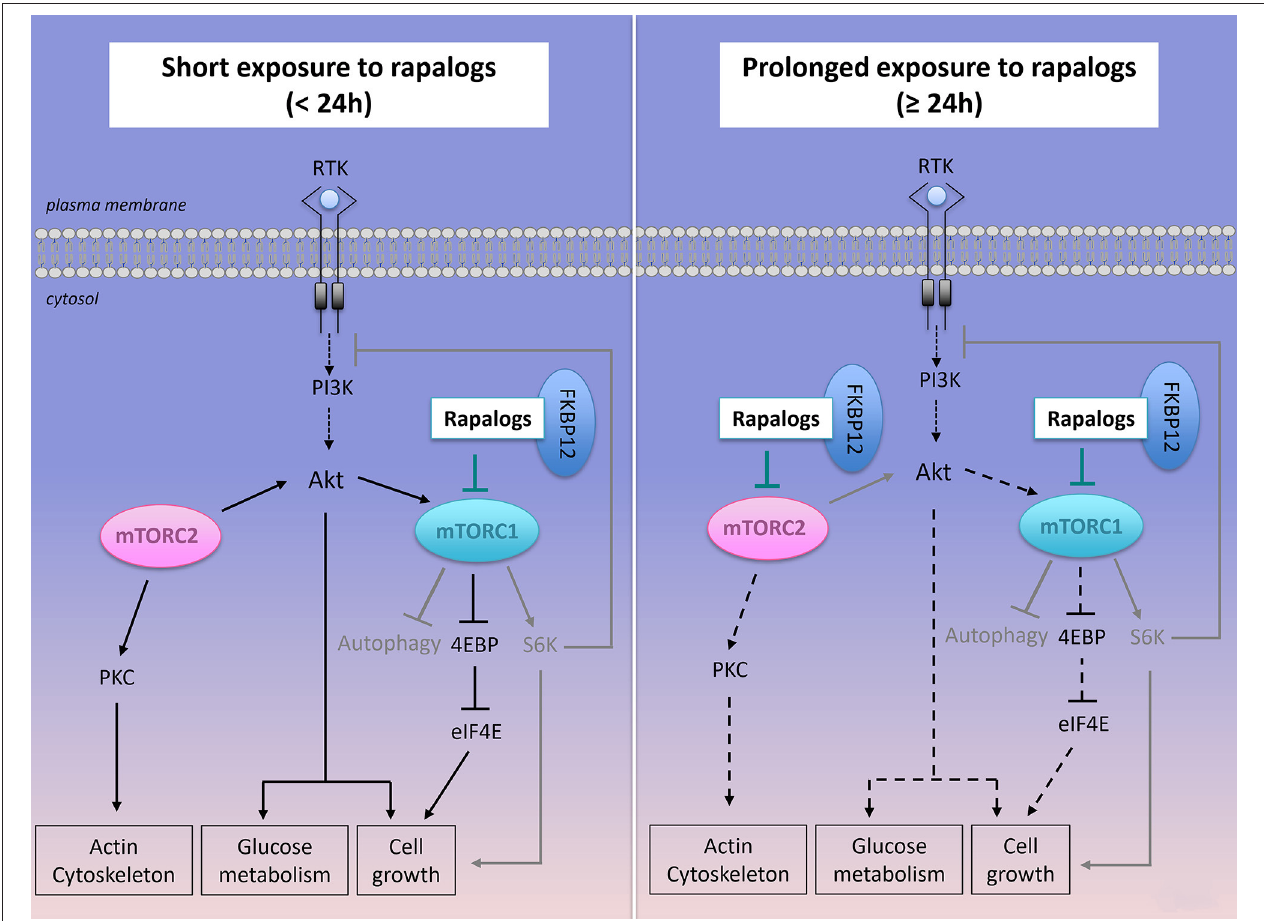
FIGURE 4 | Effect of short or prolonged exposure of rapalogs on mTORC1, mTORC2 activities and on cancer survival and proliferation. Rapalogs form a complex with FKBP12 that inhibits mTORC1 activity, S6K activation but only partially reduces 4EBP signaling. Rapalogs also prevent the feedback inhibition on the PI3K/Akt signaling, thus converging toward Akt activation and cancer cell survival. Prolonged exposure to rapalogs partially inhibits mTORC2 assembly and mTORC2 functions on Akt